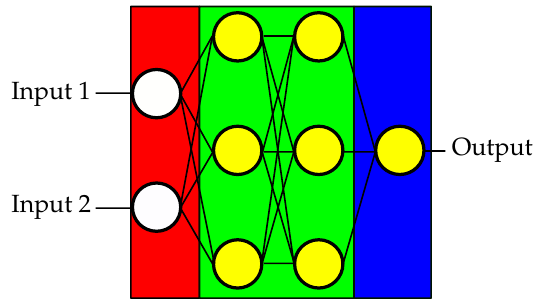
Figure 8. Example of a single model like Model-A or Model-dT with two inputs (Input 1 and Input 2) and one output (Output). White neurons represent input neurons and yellow neurons represent LSTM